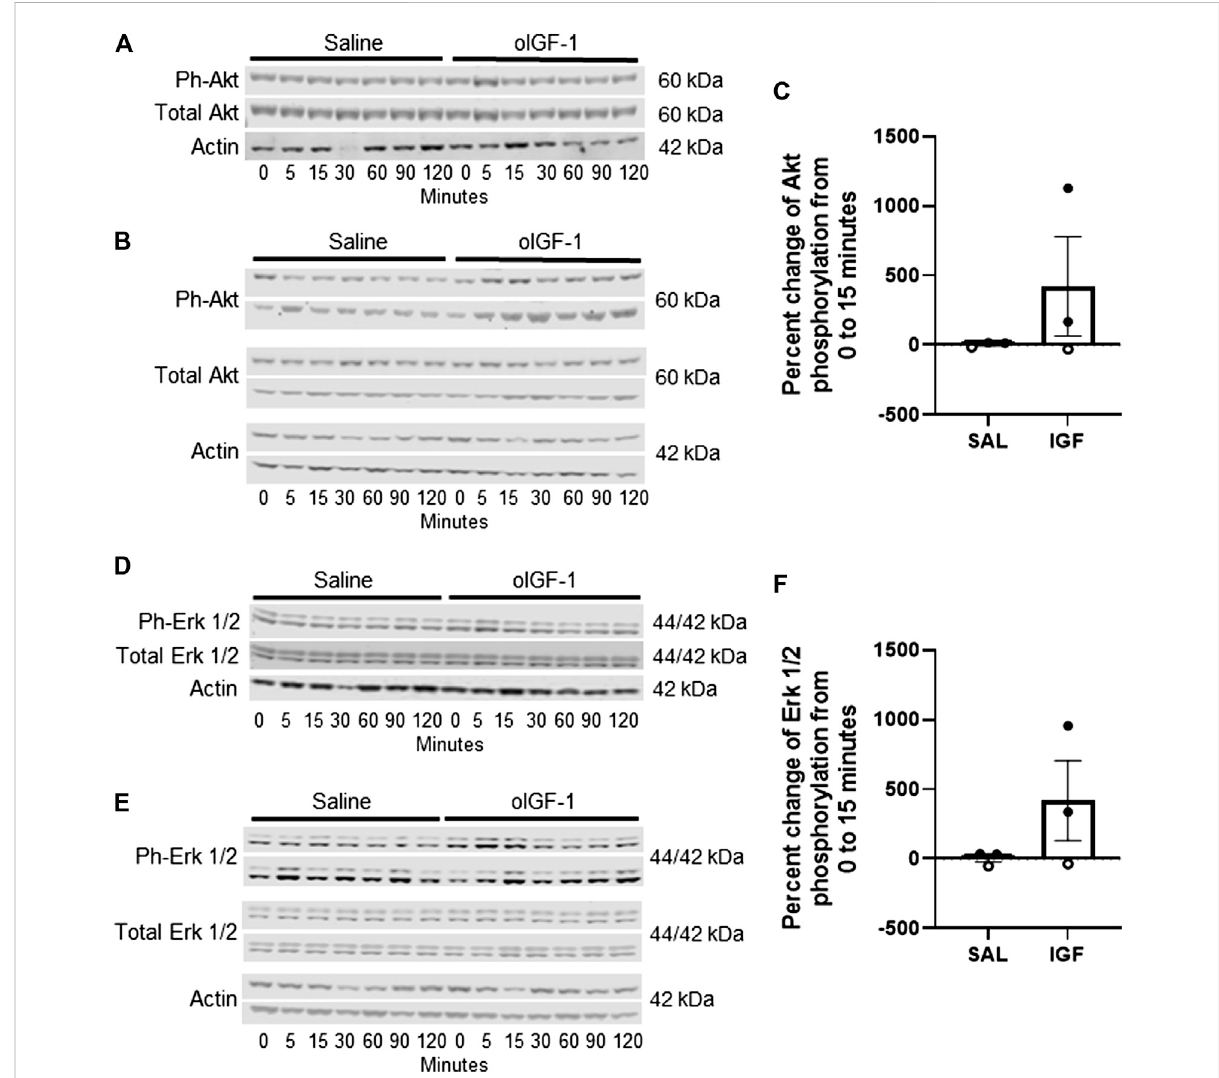
FIGURE 4 Protein expression of anabolic targets in biceps femoris muscle after acute infusion of recombinant ovine IGF-1 (oIGF-1). Blots of phosphorylated (Ser473) and total Akt in (A) 1 pair of twin animals that received oIGF-1 at 22 μ g · h − 1 or saline and (B) 2 pairs of twin animals that receivedoIGF-1at220 μ g · h − 1 orsaline. (C) GraphrepresentsthepercentchangeinphosphorylationofAktfrom0to15 minofinfusion.Opencircles represent the twin pair that received oIGF-1 at 22 μ g h − 1 or saline and closed circles represent the twin pairs that received oIGF-1 at 220 μ g · h − 1 or saline. Blots of phosphorylated (Thr202/Tyr204) and total Erk 1/2 in (D) 1 pair of twin animals that received oIGF-1 at 22 μ g · h − 1 or saline and (E) 2 pairs of twin animals that received oIGF-1 at 220 μ g · h − 1 or saline. (F) Graph represents the percent change in phosphorylation of Erk 1/2 from 0